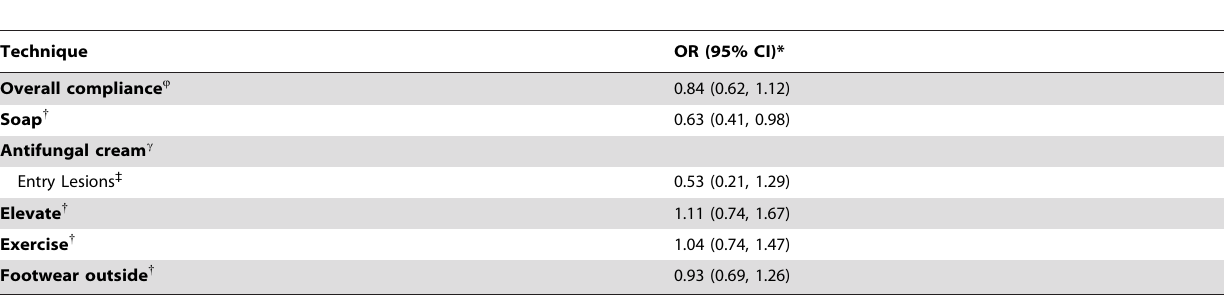
Table 8. Association between compliance to lymphedema management techniques and lymphedema progression since previous time point. Khurda District, Odisha State, India, July 2009–July